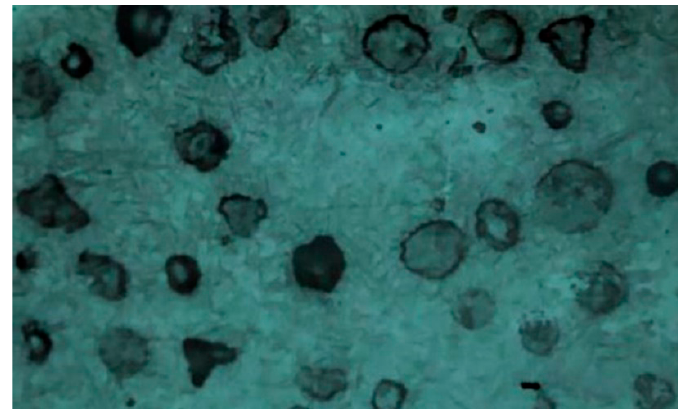
Figure 3. Bainitic microstructure (Magnification: 136×).